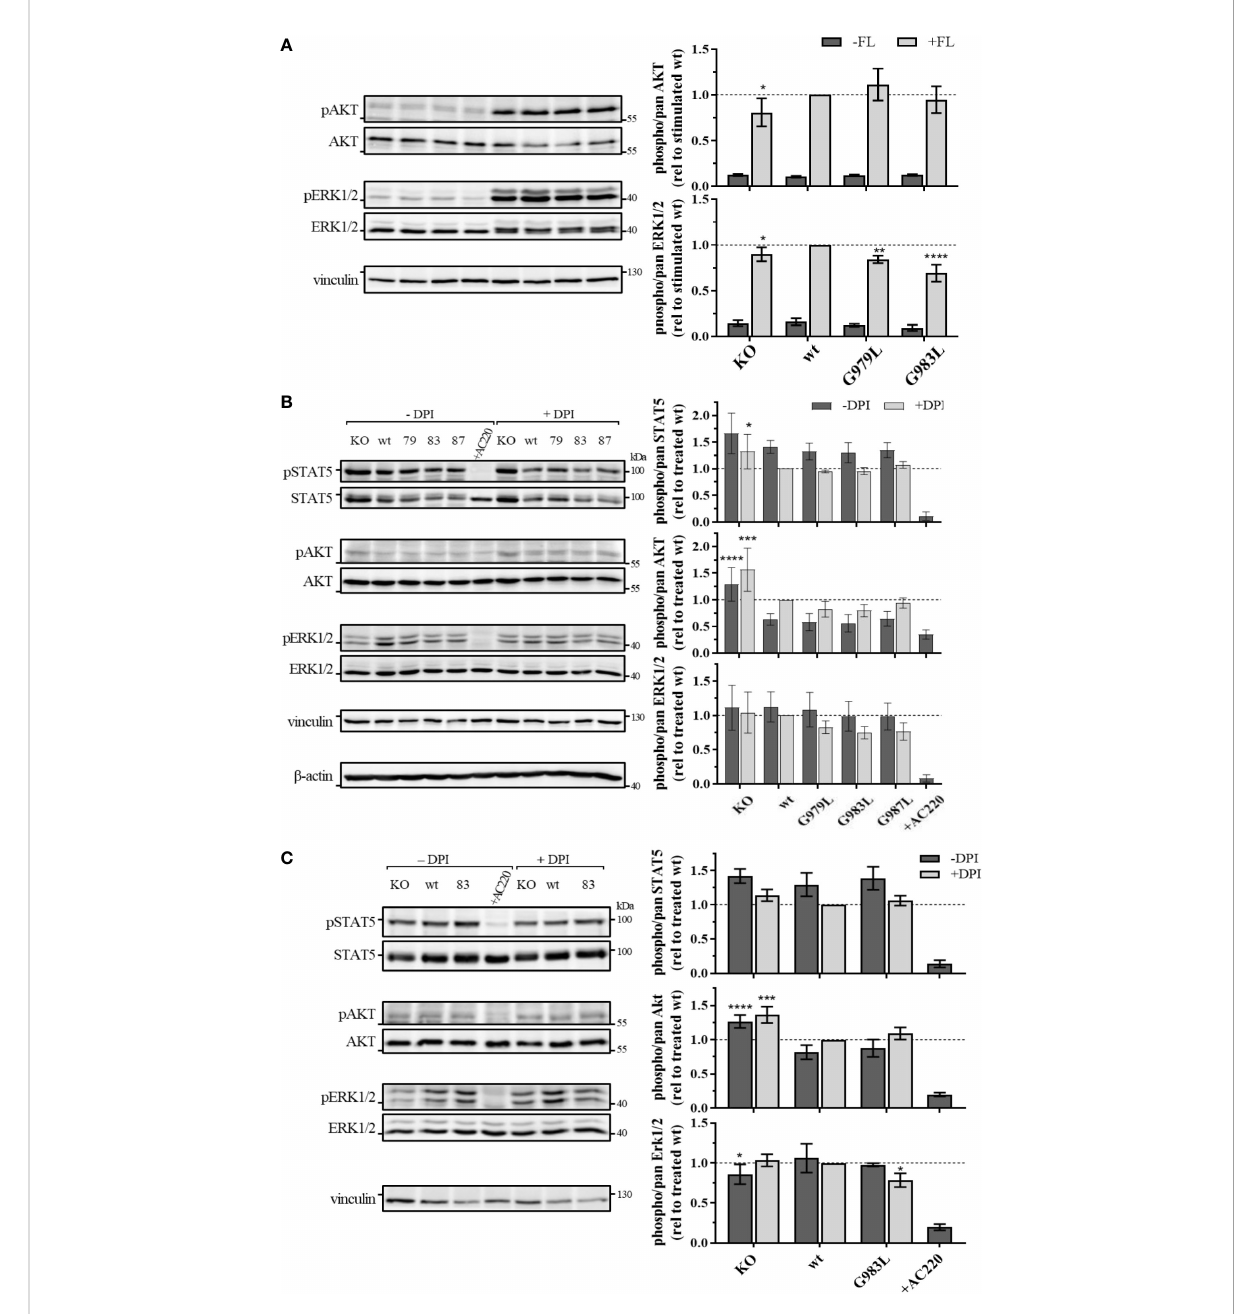
FIGURE 4 Signaling analysis of THP-1 (A) MV4-11 (B) and 32D FLT3 ITD cells expressing TMD mutant PTPRJ. (A) THP-1 PTPRJ KO cells or cells re- expressing PTPRJ wt, G979L, or G983L were starved for 4 h in serum-free medium, then stimulated with 200 ng/ml FLT3 ligand for 5 min (+FL) or left unstimulated ( – FL) and lysed in RIPA buffer. (B, C) MV4-11 and 32D FLT3 ITD PTPRJ KO cells or cells re-expressing PTPRJ wt, G979L, G983L, or G987L were starved for 4 h in serum-free medium and treated with DPI (0.5 µM), AC220 (20 nM), or mock (DMSO), as indicated, then lysed in RIPA buffer. Equivalent amounts of protein samples were separated by SDS-PAGE and blotted to a nitrocellulose membrane. Blots were fi rst probed by phospho-site speci fi c antibodies recognizing pSTAT5 (Y694), pAKT (S473), and pERK1/2 (T202/Y204). Blots were re-probed for total STAT5, AKT, and ERK1/2 and subsequently analyzed with antibodies recognizing vinculin (124 kDa) and beta-actin (42 kDa) as a loading control. Left : Representative immunoblots are shown. Dashes indicate positions of molecular weight standard bands. 79 – G979L; 83 – G983L; 87 – G987L Right : Quanti fi cation of speci fi c phosphorylation of AKT, ERK1/2, and STAT5 in relation to the total protein level. Values were normalized to FL-stimulated or DPI treated wt and are given as mean ± standard deviation, n = 3 - 4. Statistics: two-way ANOVA and Dunnett ’ s multiple comparisons test; *p ≤ 0.05; **p ≤ 0.01; ***p ≤ 0.001; ****p ≤ 0.0001 compared to respective